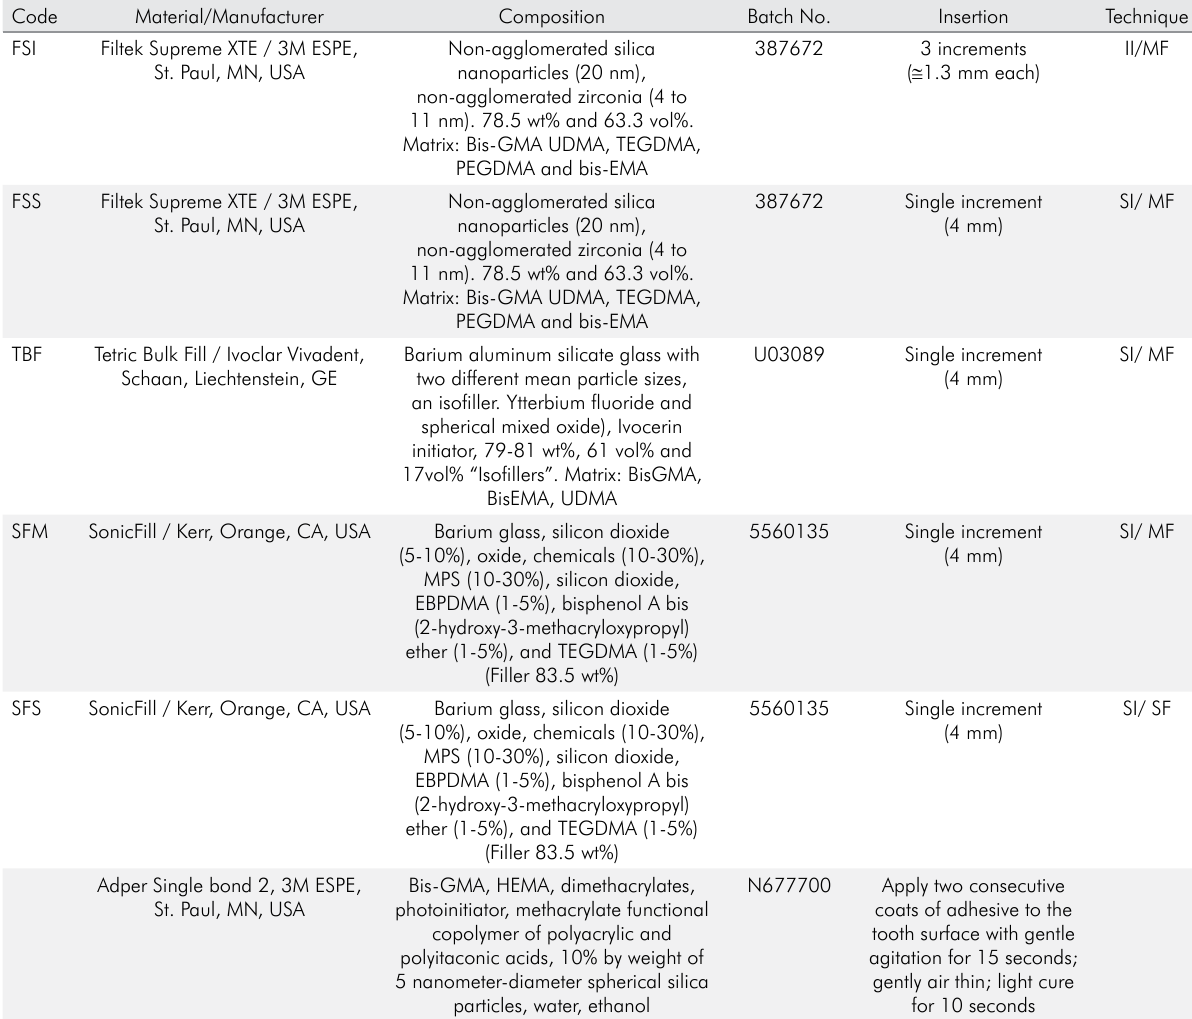
Table 1. Technique and materials used in the study. Code